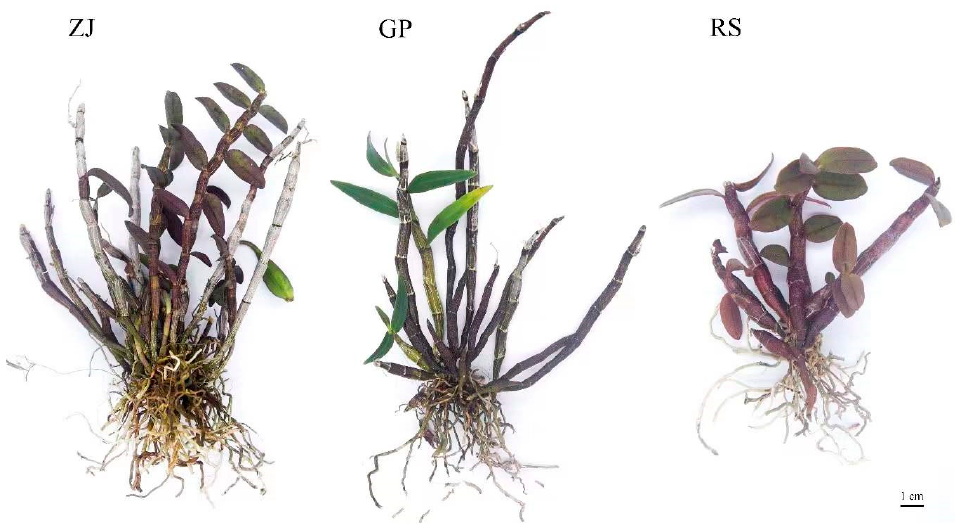
Figure 12. The appearance of D. officinale from ZJ, GP, and RS, respectively. GP represents Guiping, Guangxi Province, RS represents Shaoguan, GP represents Guangdong Province, and ZJ represents Zhejiang Province.